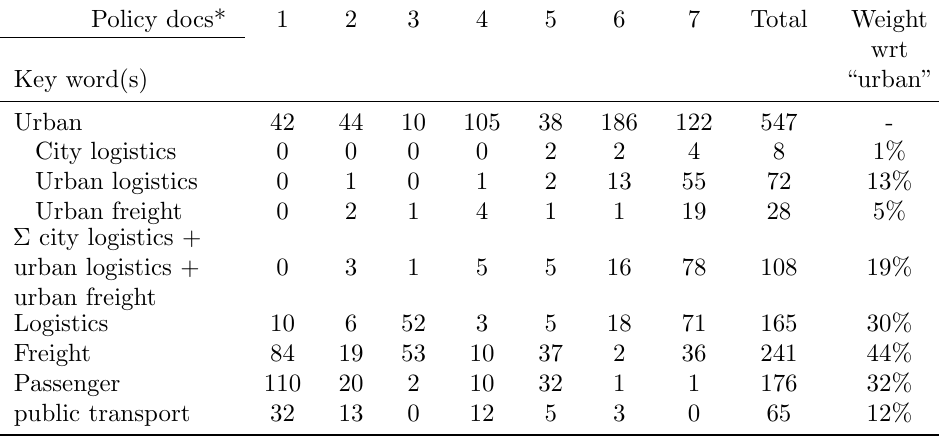
Table 2: Recurrences of UFT related words in the seven policy documents (absolute